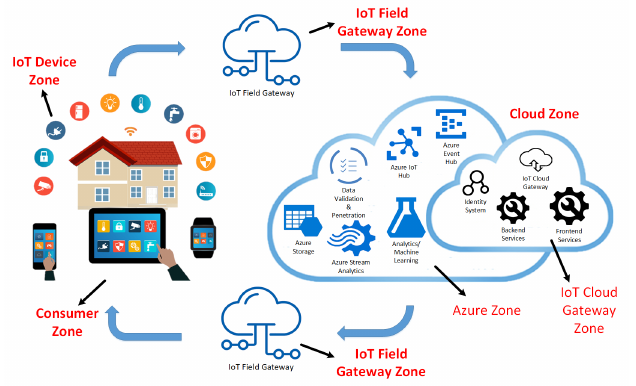
Figure 3. Smart Home